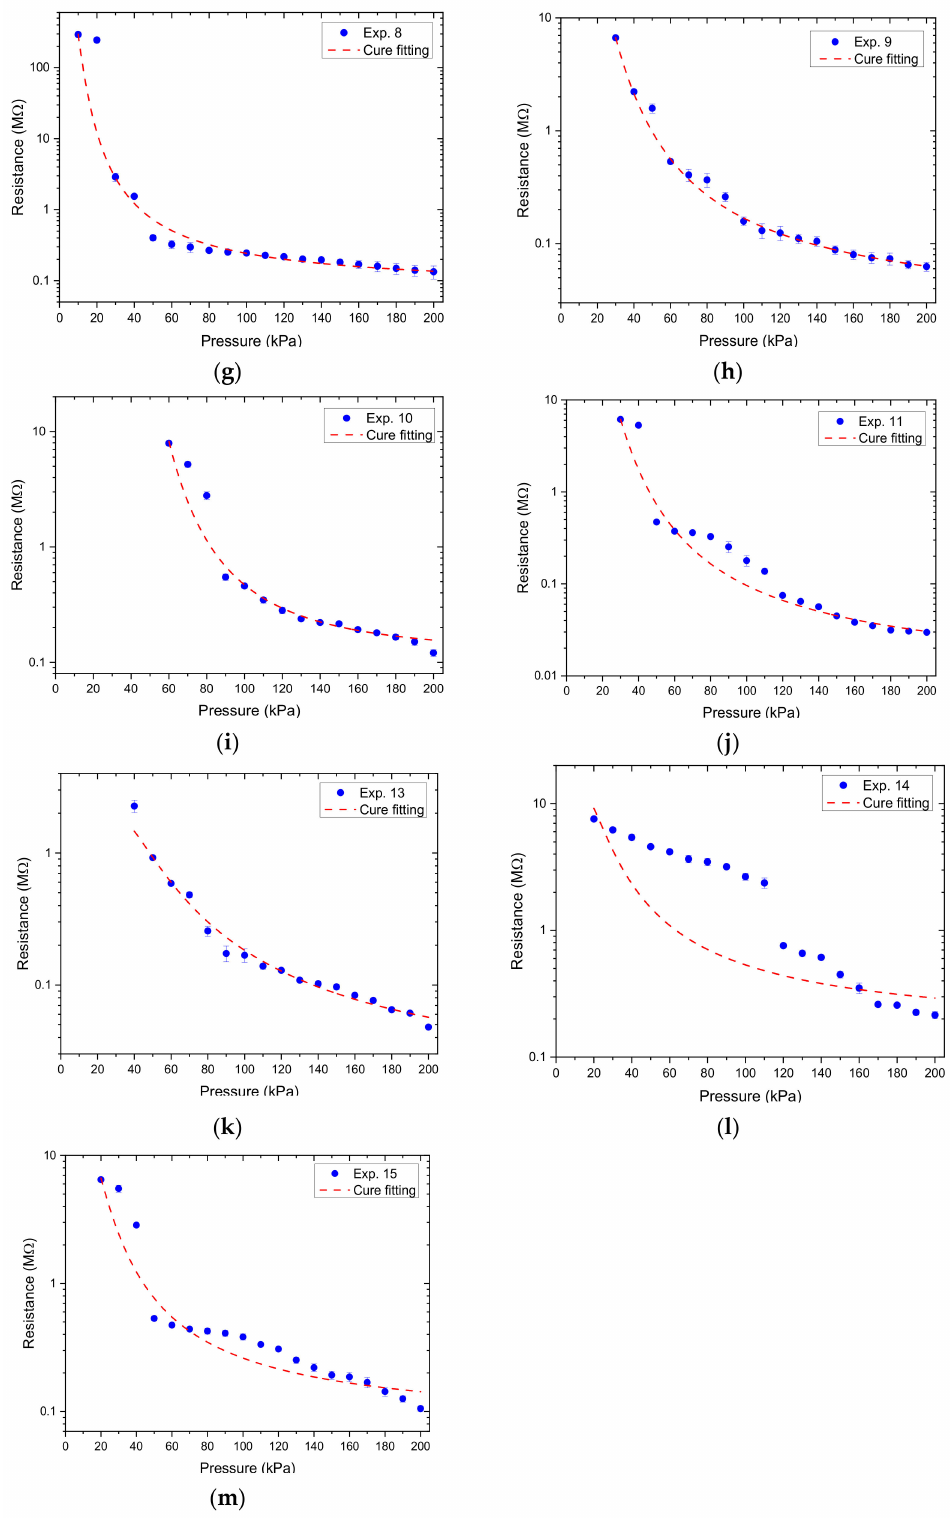
Figure 17. The resistance output as a function of applied pressure for different grid microstructures in which ( a – m ) corresponds to experiments